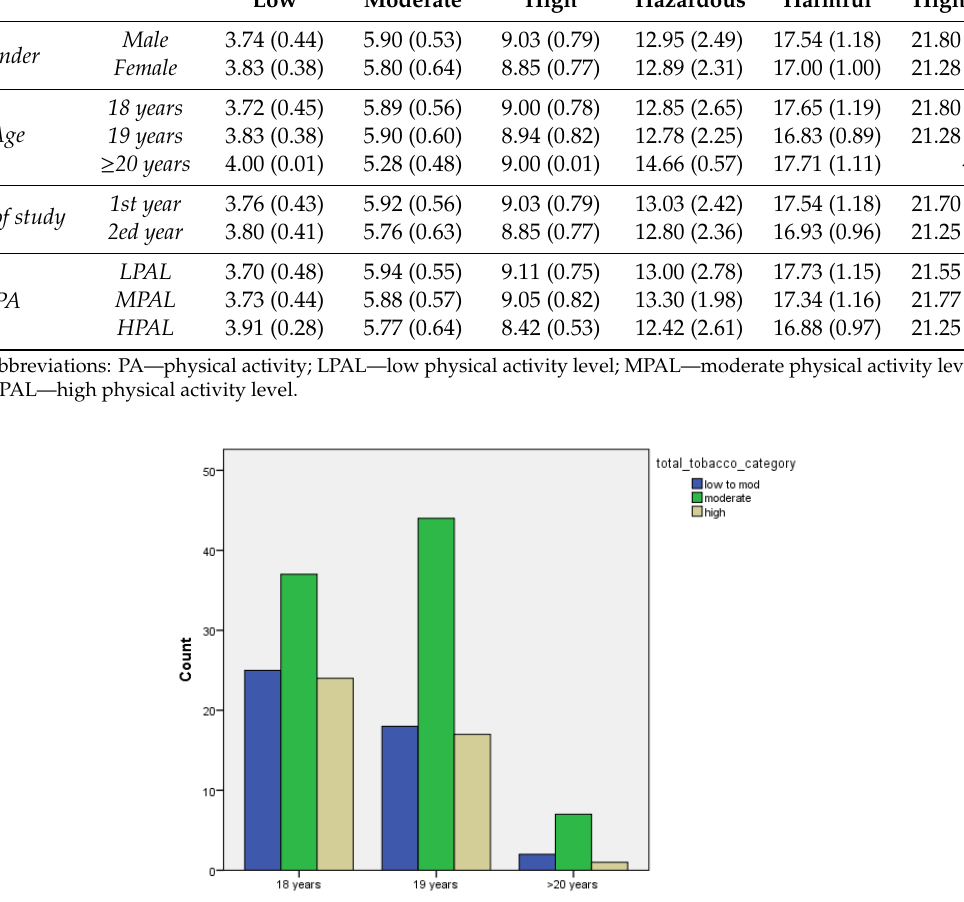
Table 1. Descriptive statistics of study variables.